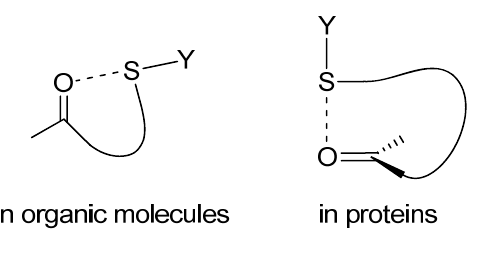
Figure 2. Nonbonded S···X interactions in organic molecules and